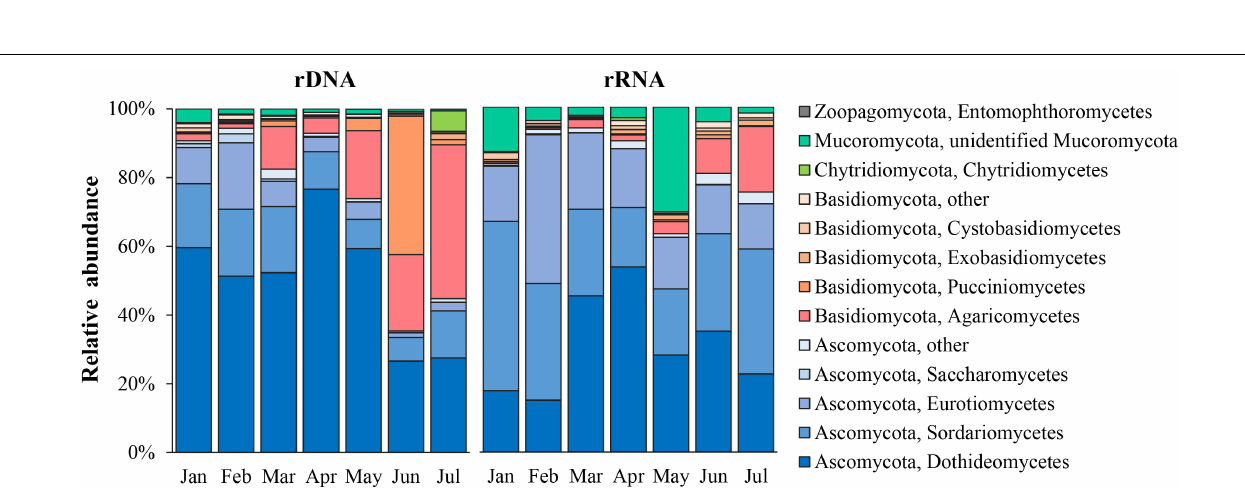
Frontiers in Microbiology |